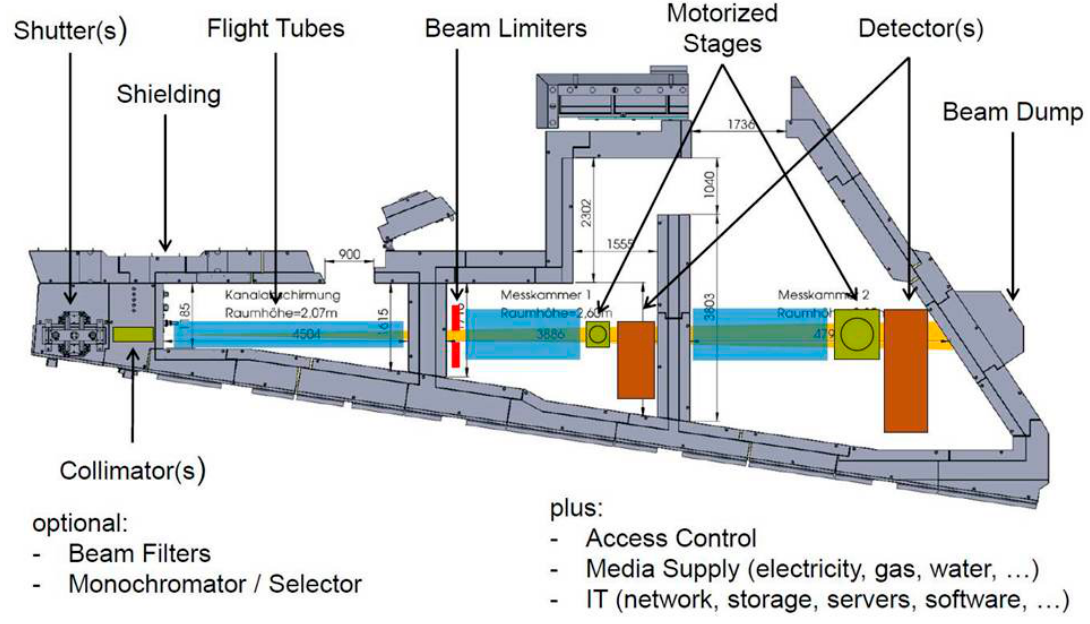
Figure 1. The ANTARES facility (modified from [3] with permission.).